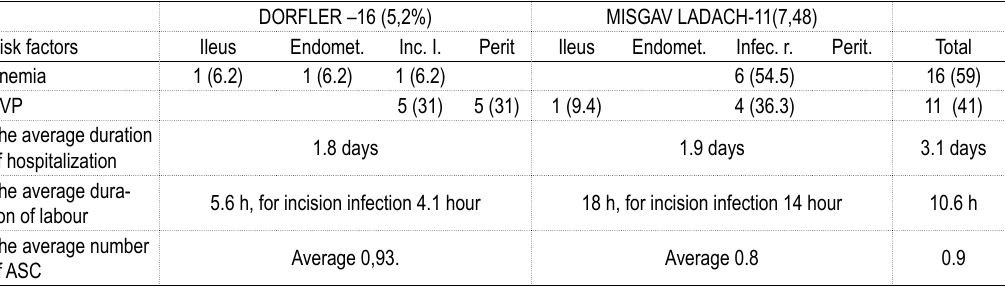
Table 4. Common risk factors in developed inflammatory complications